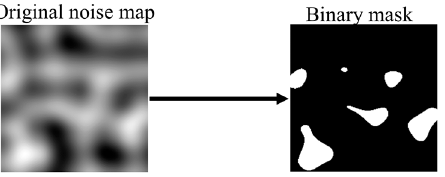
Figure 4. Example of generating a binary mask from Perlin noise. Set the values greater than 0.4 in the Original noise map (256 2 ) to 1 and other values to 0 to obtain a Binary mask (256 2 ).